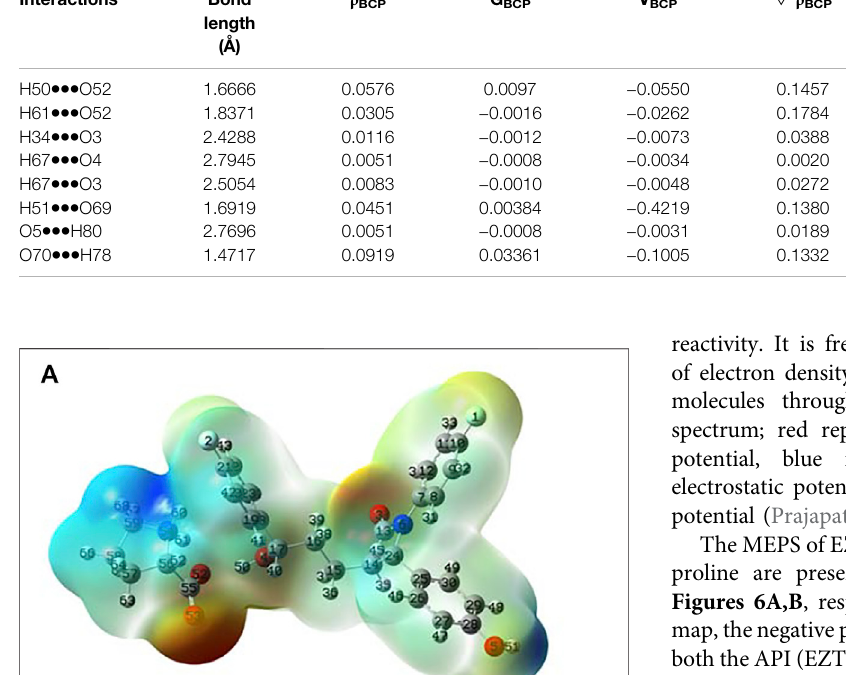
TABLE 3 | Geometrical parameters (bond length) and topological parameters of bonds of interacting atoms in the cocrystal (EZT+2L-proline): electron density ( ρ BCP ), Laplacian of electron density ( ▽ 2 ρ BCP ), electron kinetic energy density (G BCP ), electron potential energy density (V BCP ), bond ellipticity ( ε ), total electron energy density (H BCP ) at bond critical point (BCP), and estimated hydrogen bond energy (E int ). Interactions